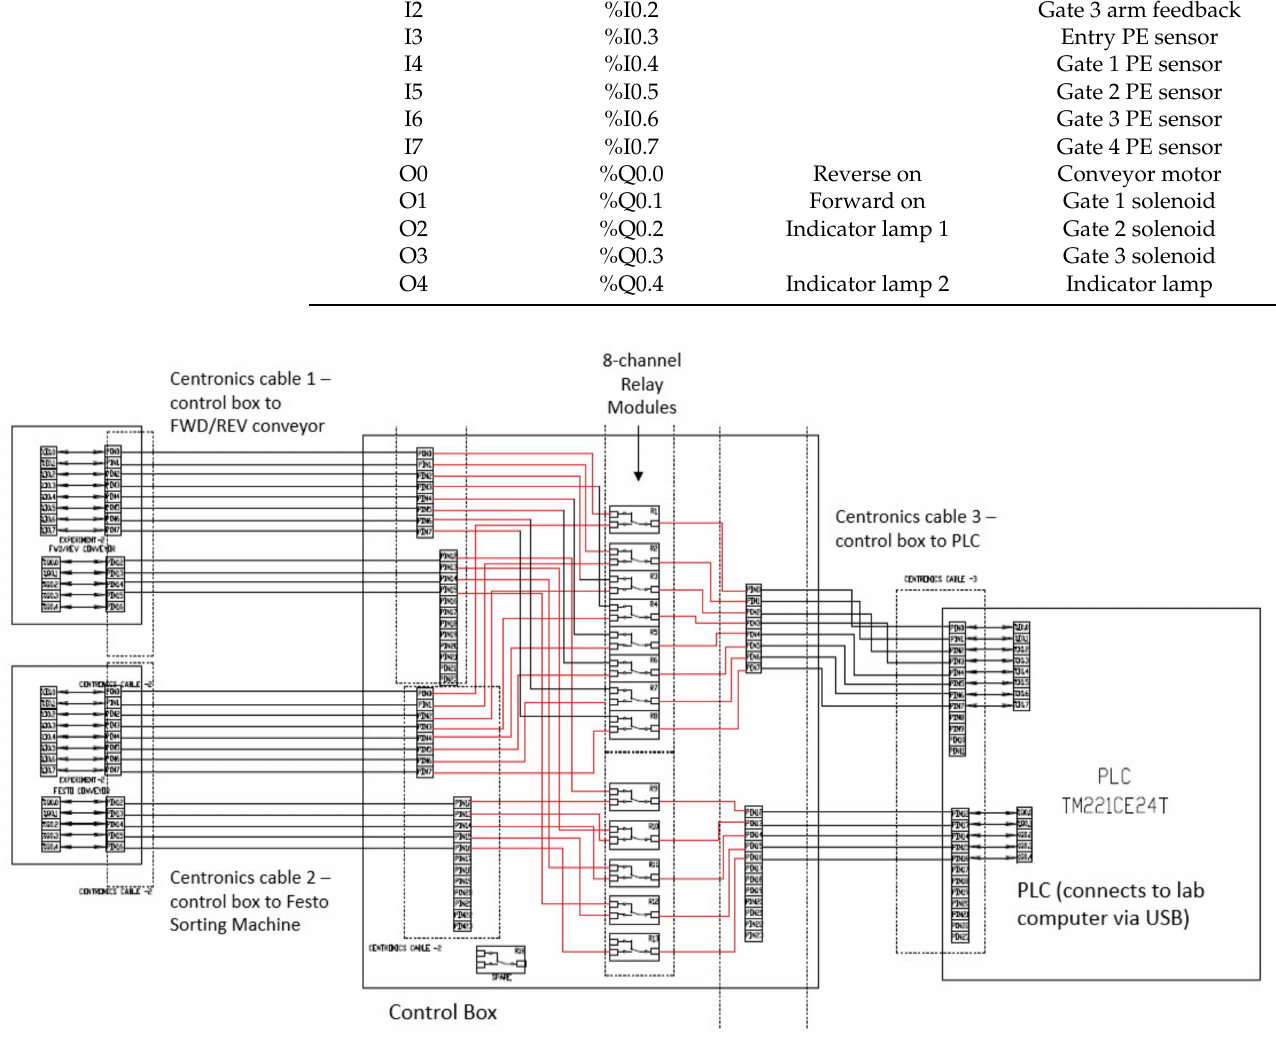
Figure 13. Wiring connections between the TM221CE24T PLC module and the two hardware.